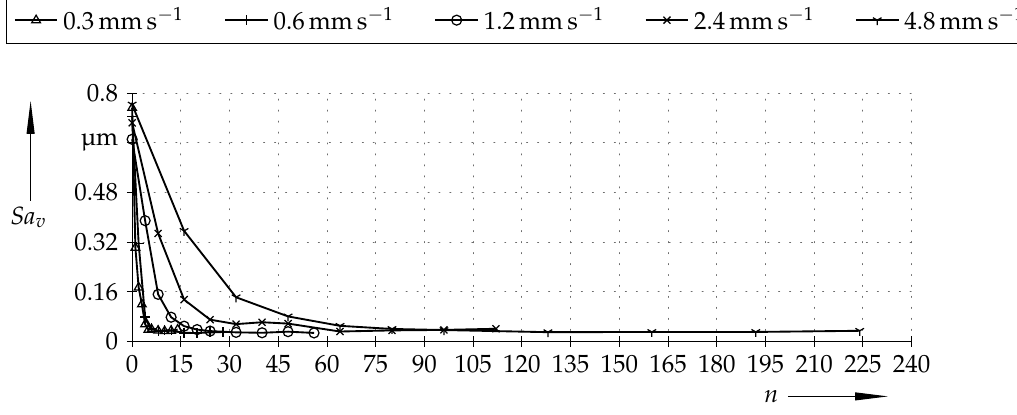
Figure 3. Average surface roughnesses Sa v of the pipe inner surface over n for different velocities v . The initial average surface roughness Sa 0 is located at the position n = 0.